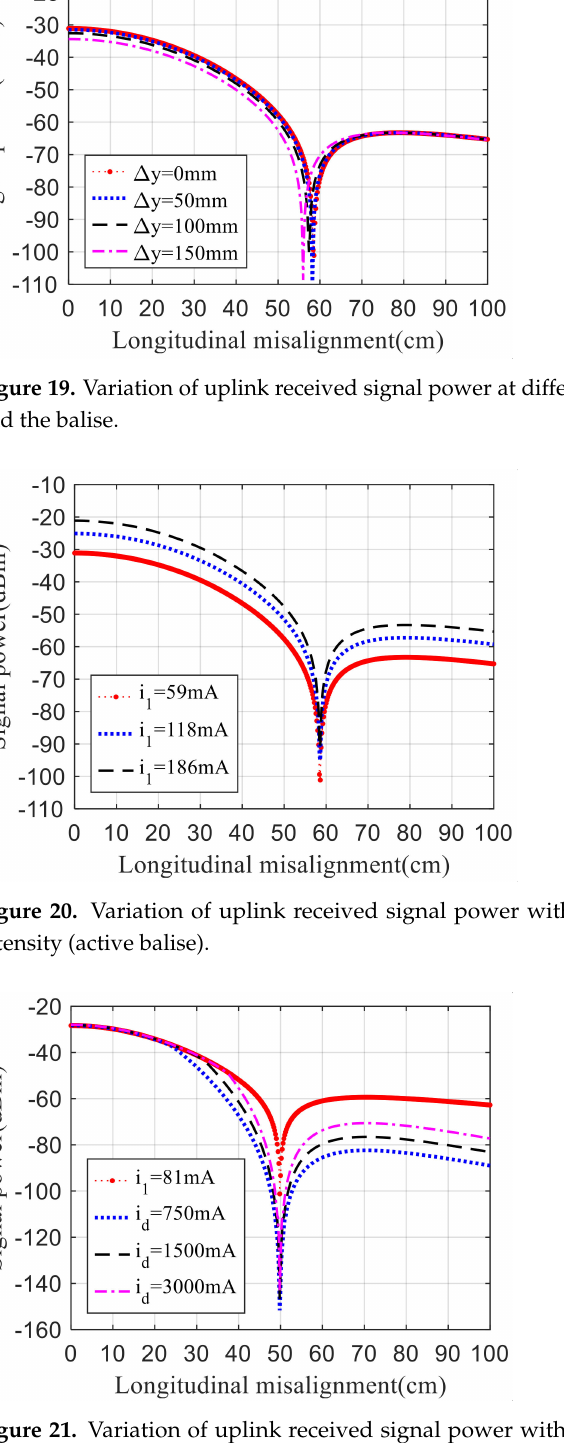
Figure 21. Variation of uplink received signal power with different tele-powering signal current intensity (passive